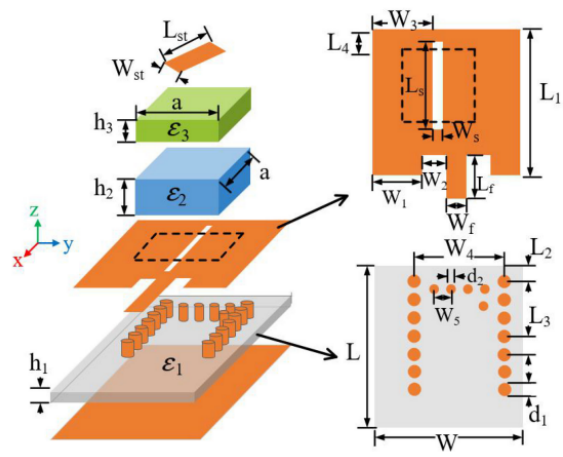
Figure 10. Overall configuration of a dual-band dual-CP DRA [52]. Table 2. Comparison between different single-fed circularly polarized DRAs.